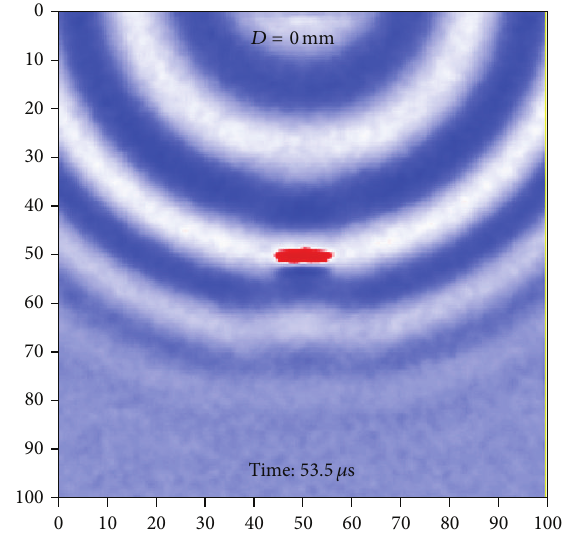
Figure 5: Snapshot at 53.5 𝜇 s taken from the ultrasonic wave propagation video clip in the free